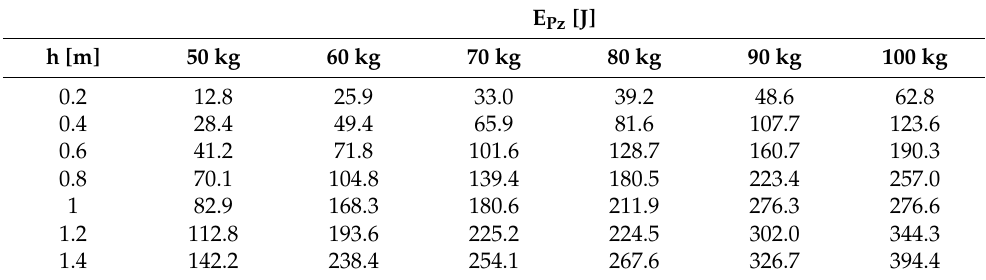
Table 4. Values of residual positional energy E Pz for individual tests with the pyramidal impactor.